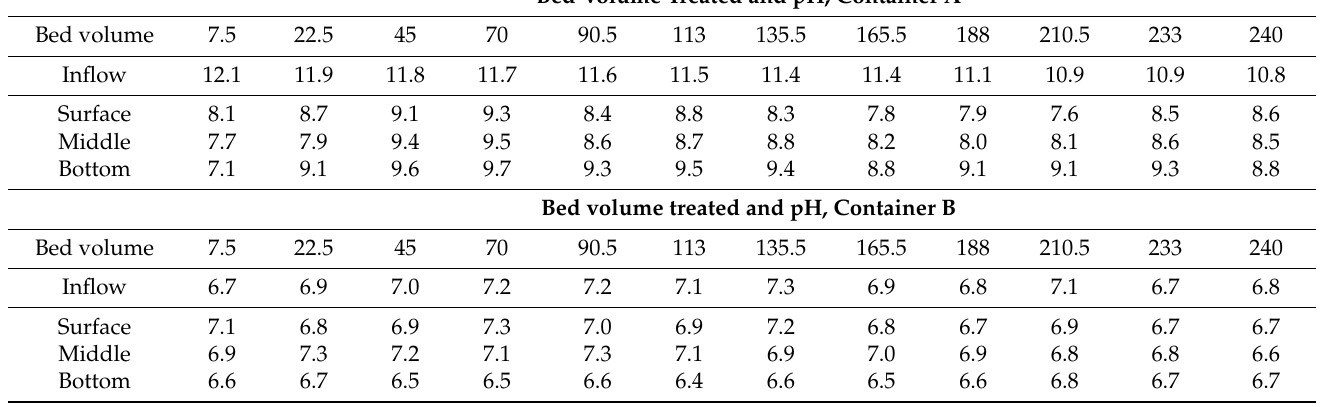
Table 3. The pH changes in container A (Polonite filtration) and B (glass bead filtration) during 32 days pumping of hypolimnetic water. Rounded averages of three measurements in each water layer (surface, middle, bottom) are given as well as inflow pH values in relation to the consecutive bed volumes treated in